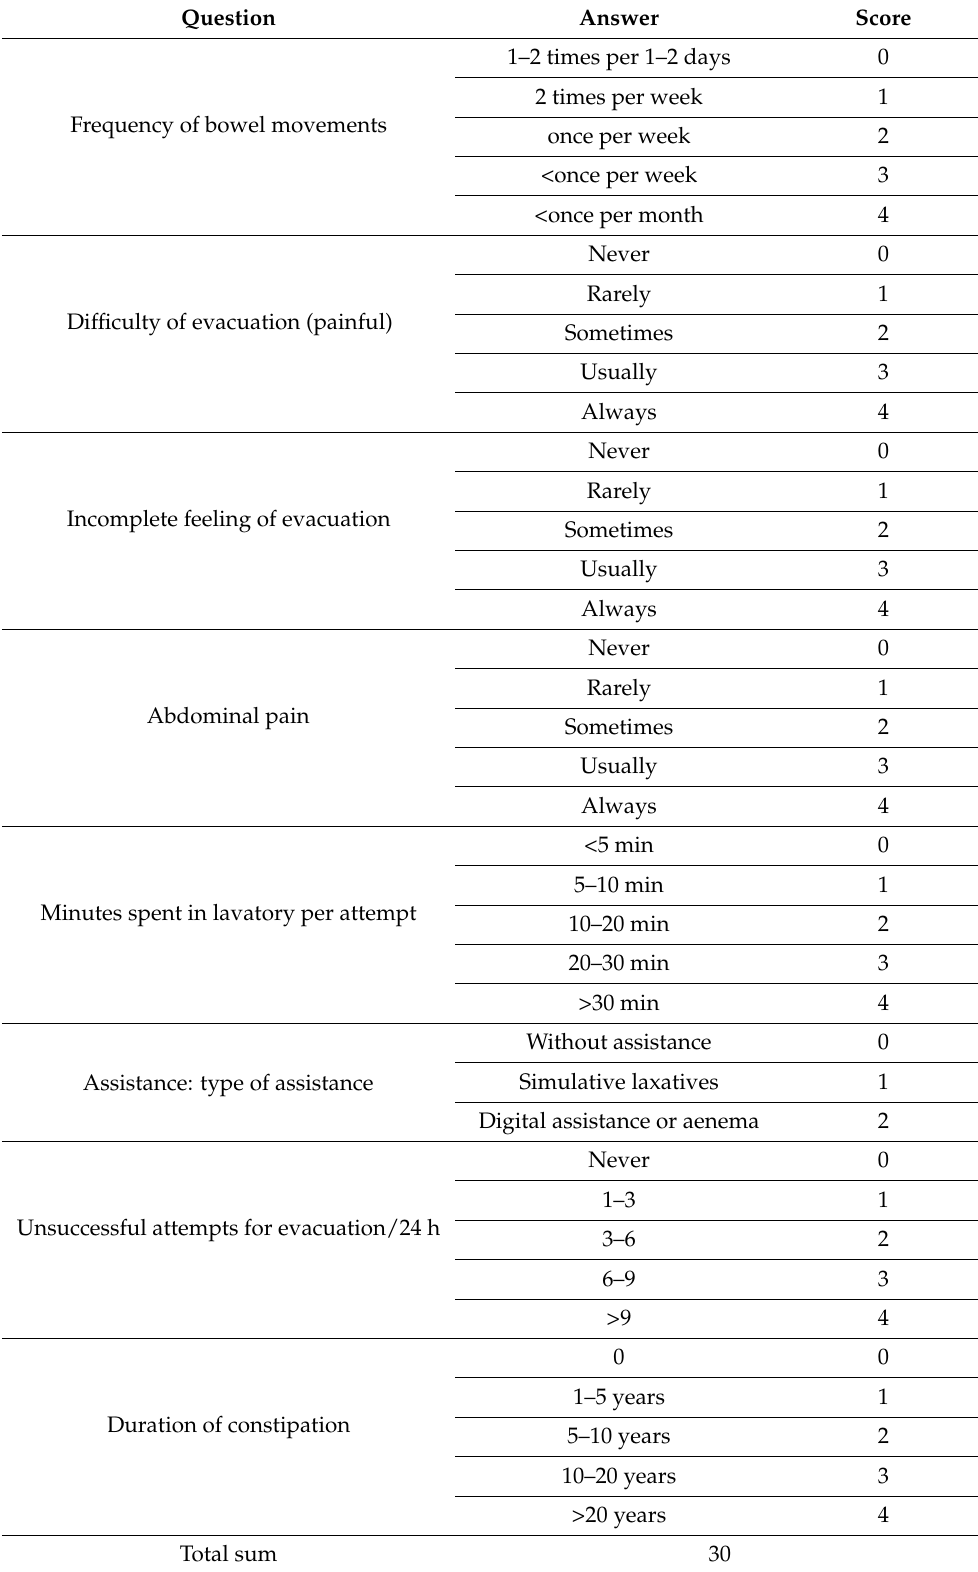
Table 1. Questionnaire underlying the constipation-scoring algorithm, modified based on [34]. Question Answer Score